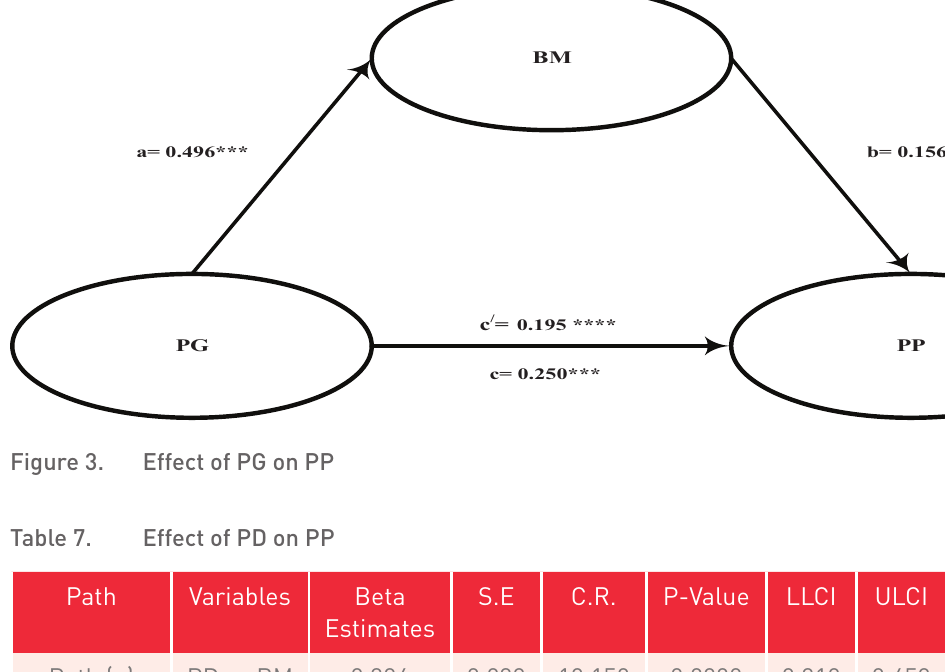
Figure 3. Effect of PG on Effect of PD on PP Path